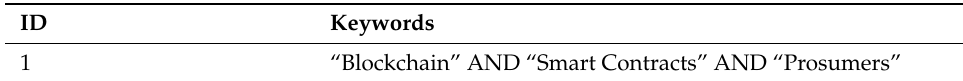
Table 4. List of